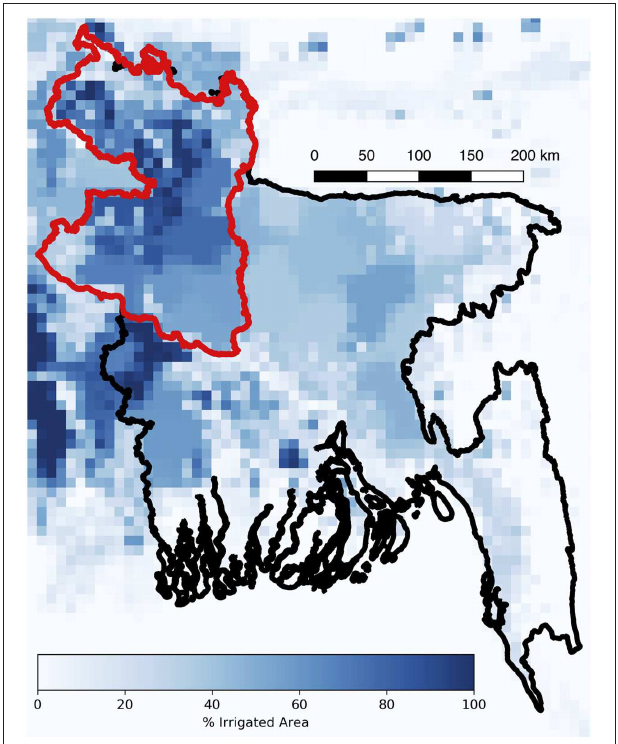
FIGURE 1 | Fraction of irrigated area in Bangladesh (Siebert et al., 2013). Country boundary in black, Northwest Bangladesh region (i.e., Rangpur and Rajshahi divisions) boundary in red. The irrigated area data were accessed from FAO AQUASTAT http://www.fao.org/nr/water/aquastat/irrigationmap/.